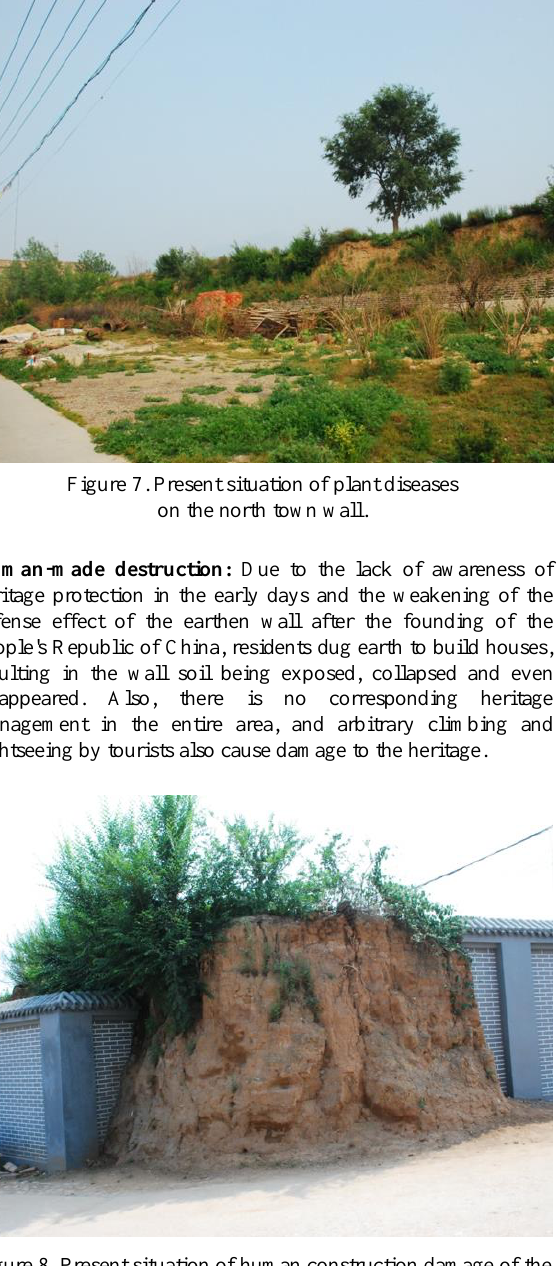
Figure 6. Present situation of weathering and collapse in the northwest corner of the town wall.